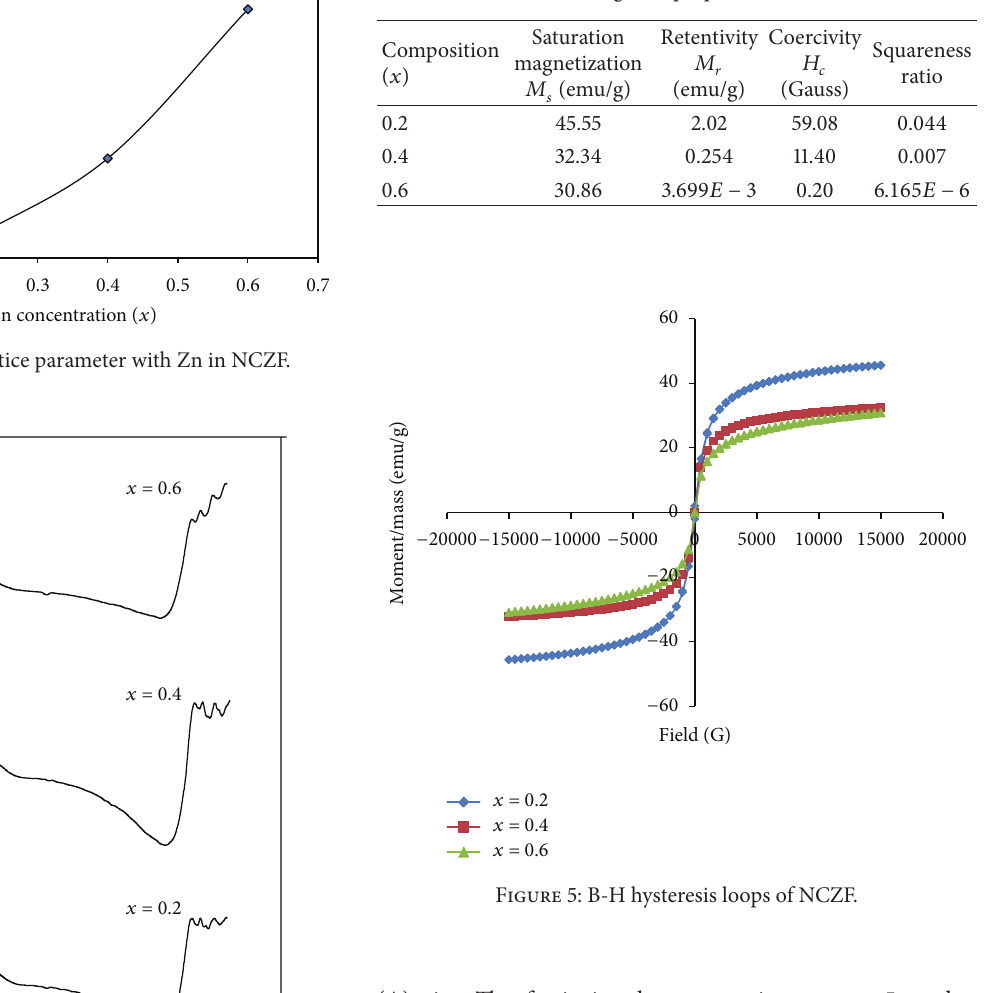
Table 2: Magnetic properties of NCZF.